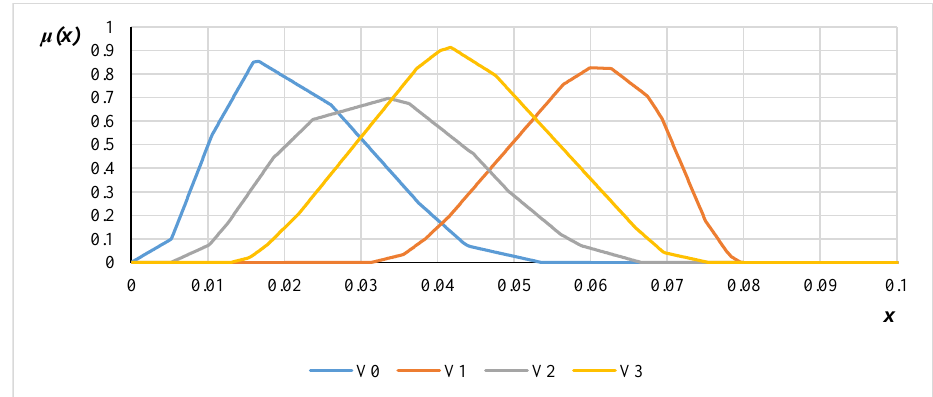
Figure 14. Total influence r of alternatives when analysing positive relationships.